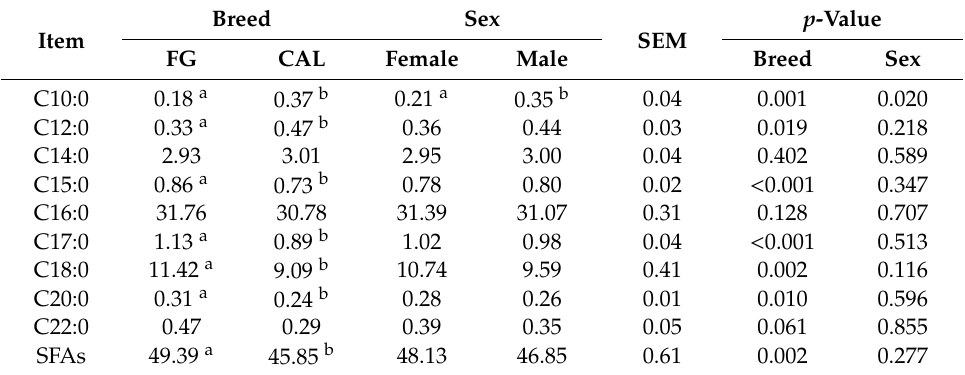
Table 3. Percentages of saturated fatty acids in the total fatty acid pool in intramuscular fat ( Longissimus thoracis et lumborum ) in female and male Californian and Flemish Giant Gray rabbits (arithmetic means ±